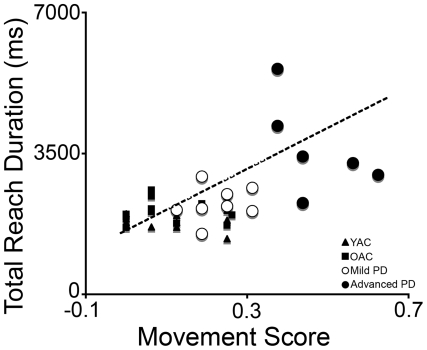
Correlation between movement score and total reach duration.The line represents the regression of the Parkinson's diseased groups combined. Note the close relationship between the two measures.